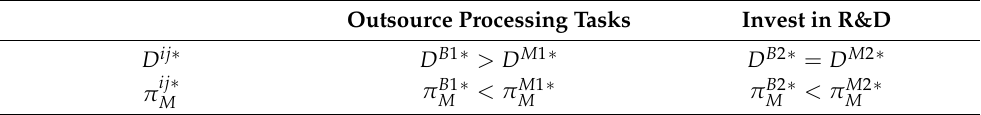
Table 3. Comparison of government subsidy strategies under the fixed processing strategy.